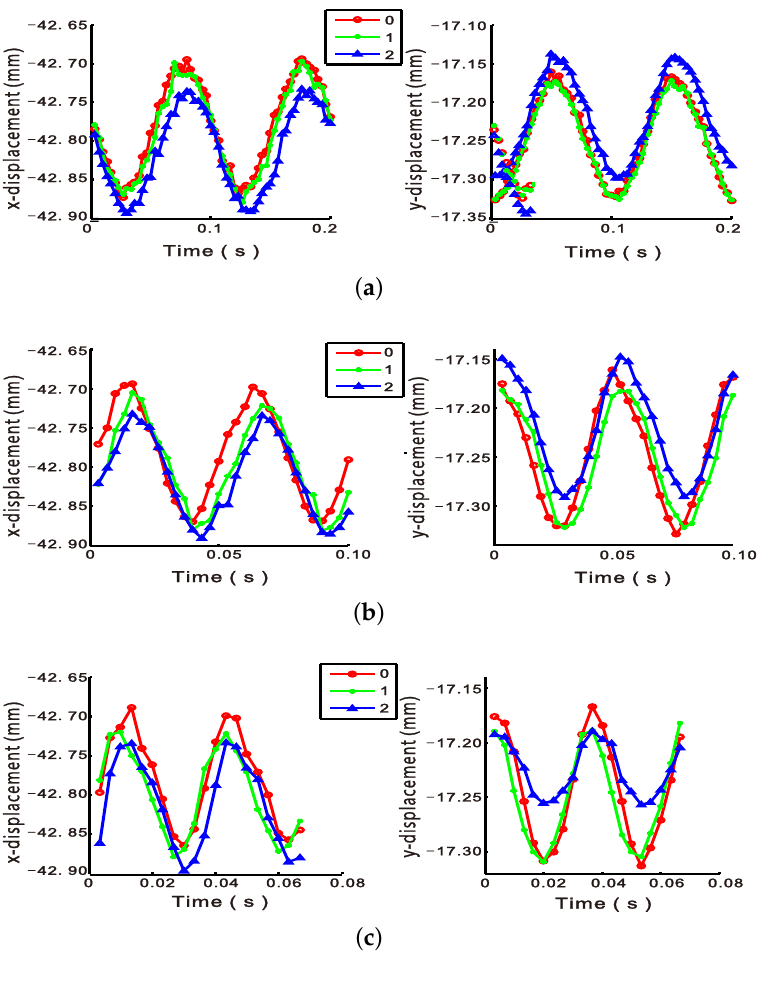
Figure 8. The in-plane motion with different additional weight (left: x direction; and right: y direction): ( a ) 600 rpm; ( b ) 1200 rpm; and ( c ) 1800 rpm.